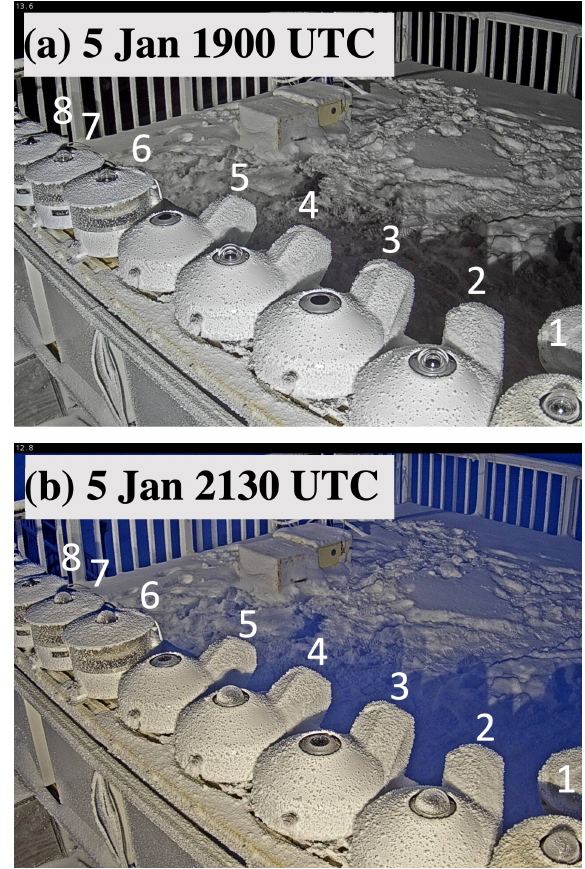
Figure 7. From CAM1, a freezing fog event in progress on 5 Jan- uary and resulting in riming. (a) Ventilators operating normally dur- ing the riming event. (b) After the image in (a) was captured, the ventilators were unpowered resulting in icing on domes after sev- eral hours of equilibration. Numbers refer to the system positions from Fig.